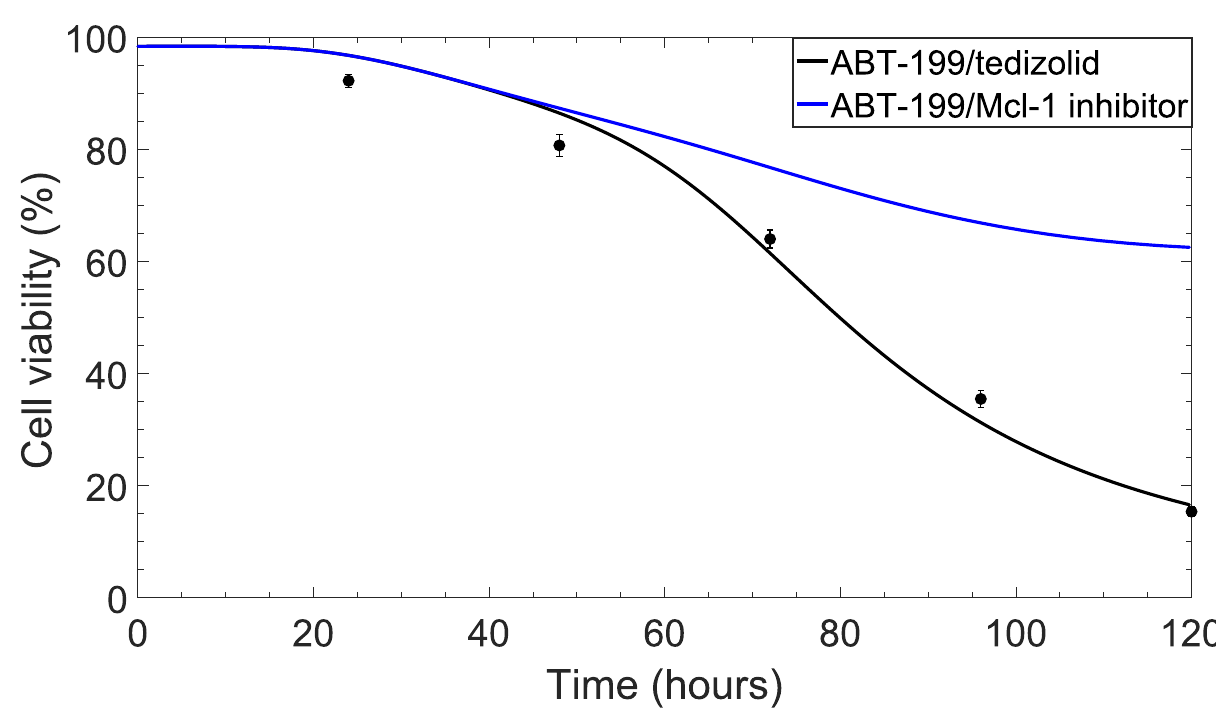
Fig 6. Cellular viability for 400 nM venetoclax treatment in combination with either 5,000 nM tedizolid treatment or an Mcl-1 inhibitor. Solid lines indicate the results of the mathematical model. Experimental data points for venetoclax/tedizolid combination therapy are shown for reference.